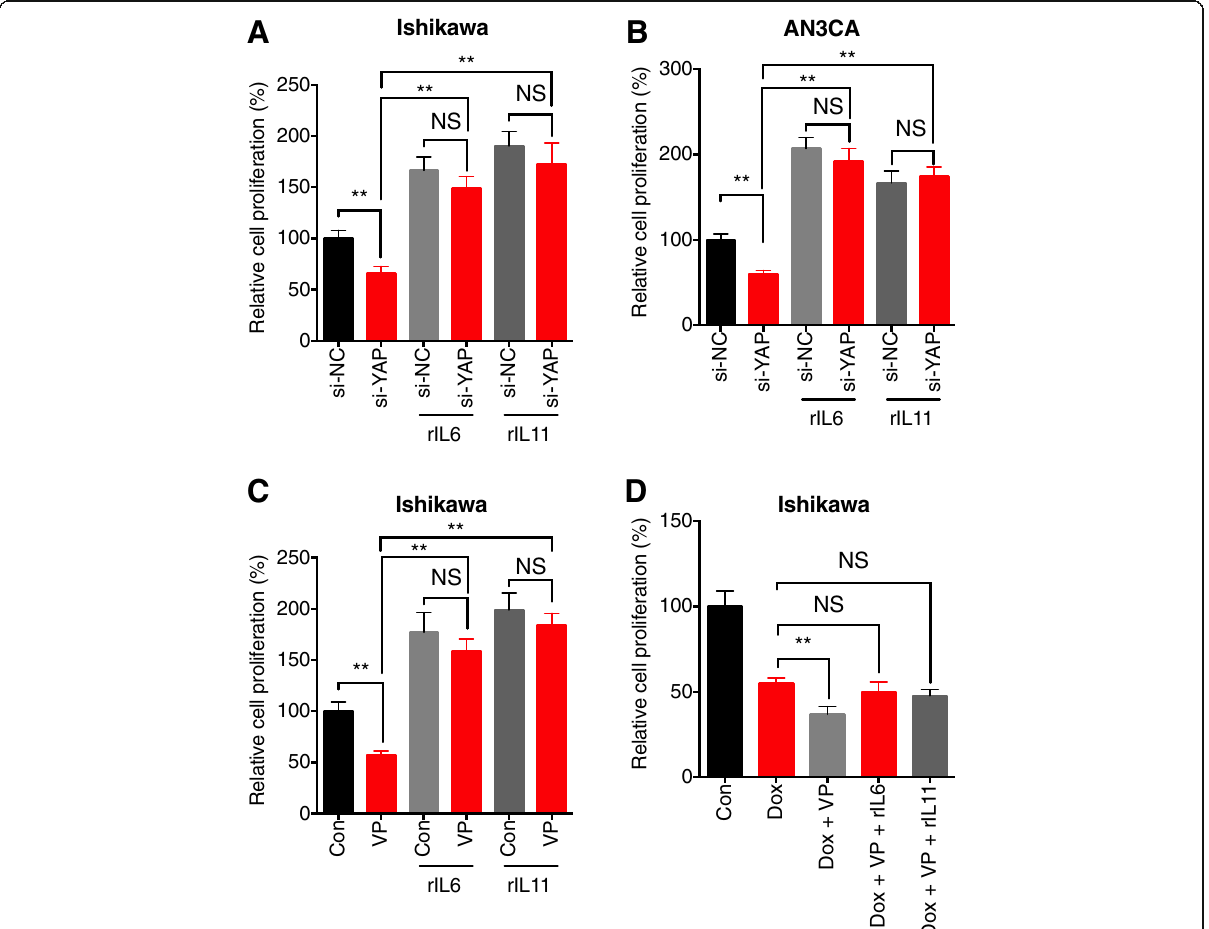
Fig. 4 Both IL-6 and IL-11 are involved in YAP regulated malignancy of EC cells . After transfected with si-NC or si-YAP for 12 h, Ishikawa ( a ) or AN3CA ( b ) cells were further treated with rIL-6 (200 ng/ml) or rIL-11 (200 ng/ml) for 48 h. The cells proliferation was tested by CCK-8 kit; ( c ) After pre- treated with or without VP (5 μ M) for 1 h, Ishikawa cells were further treated with rIL-6 (200 ng/ml) or rIL-11 (200 ng/ml) for 48 h; ( d ) After pretreated with or without Dox (1 μ M) and/or VP (1 μ M) for 1 h, Ishikawa cells were further treated with rIL-6 (200 ng/ml) or rIL-11 (200 ng/ml) for 48 h. Data are presented as means ± SD of three independent experiments. * p < 0.05, ** p < 0.01 compared with